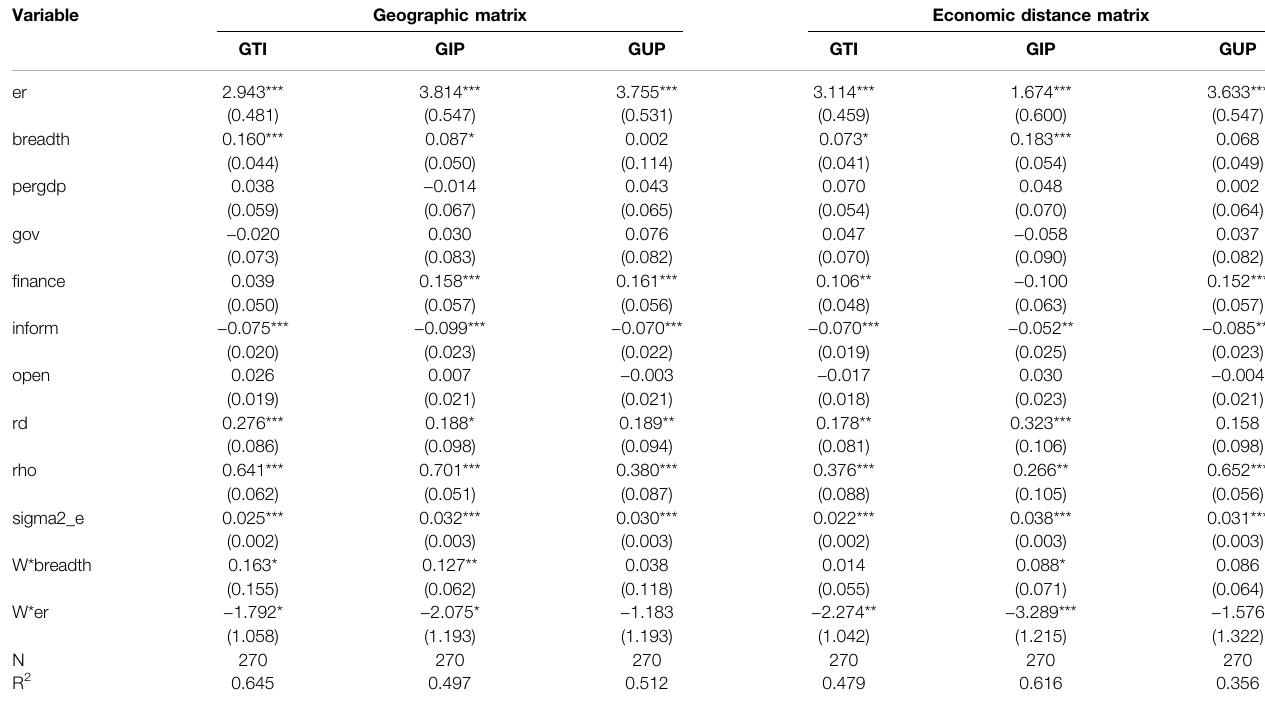
TABLE 6 | Estimation results of the robustness test.